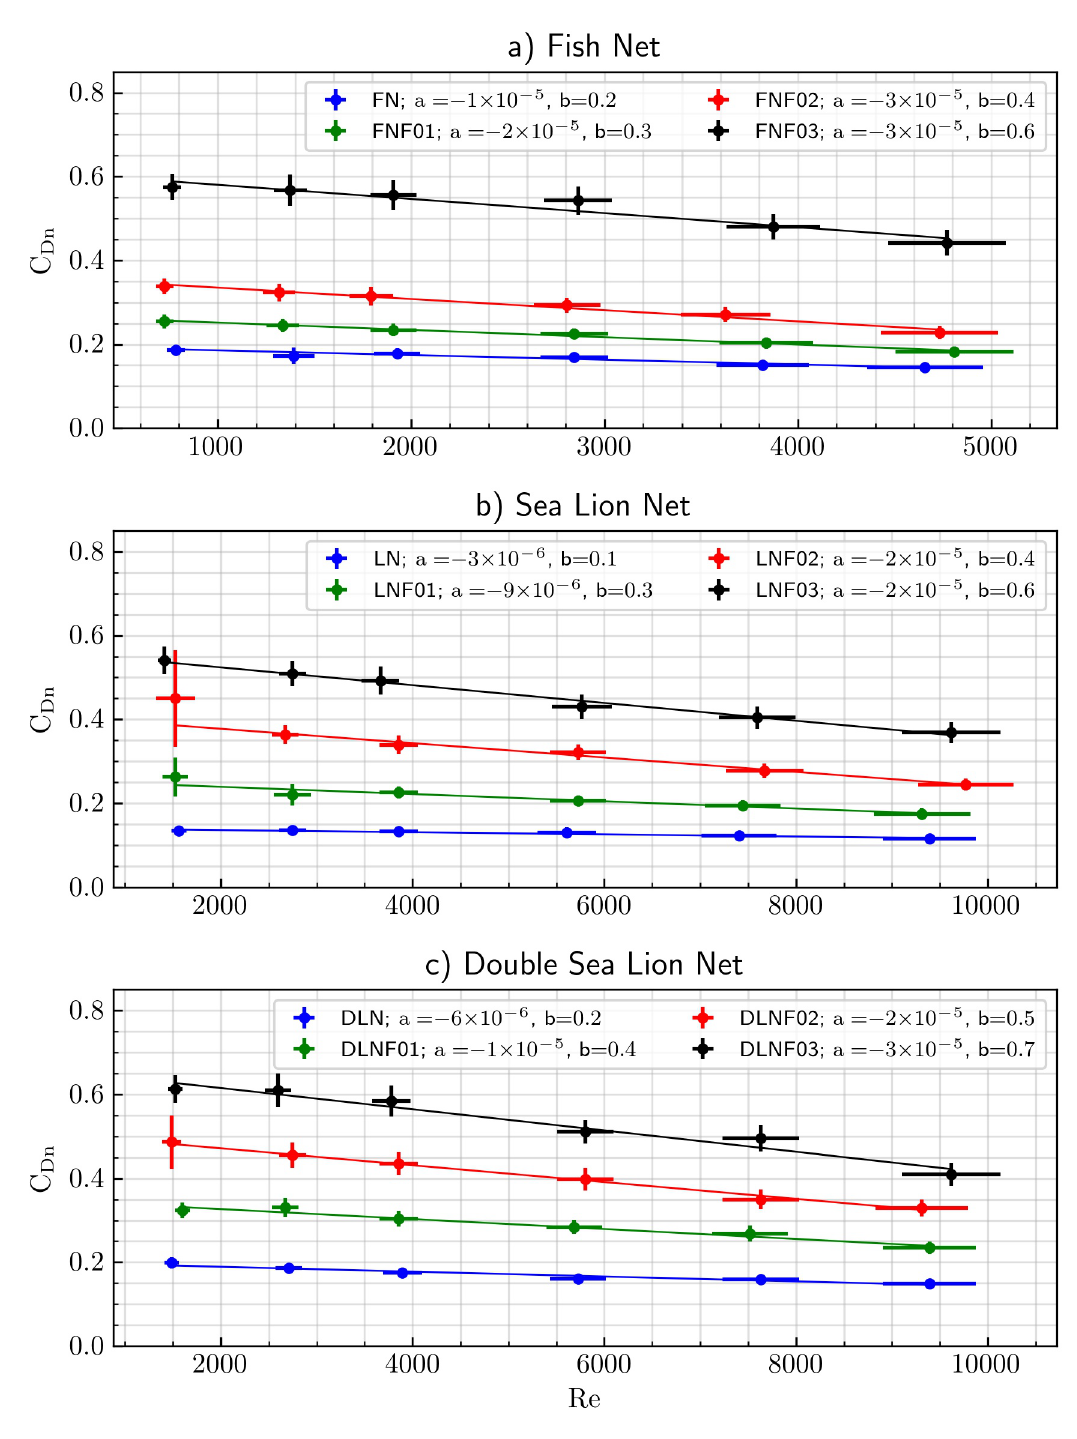
Figure 7. Experimental results of the normal drag coefficient for fish and double or single sea lion nets as a function of the Reynolds number. Experimental series, clean or without fouling, from Table 1. Lines represent a linear fit of the